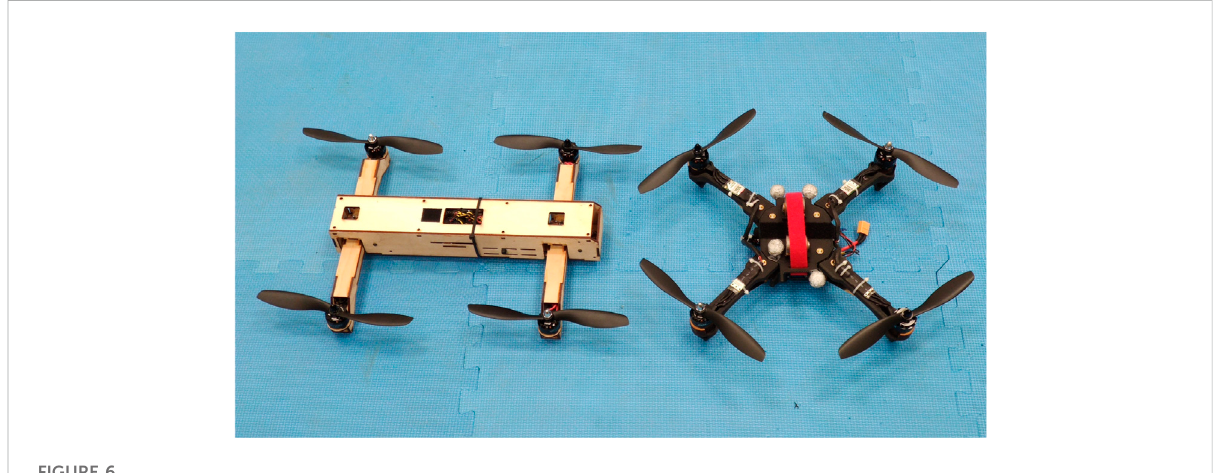
FIGURE 6 H-shaped(left)vs.X-shaped(right)quadcopterframe.UsingtheH-shapedframemeansthatasinglehingeandasinglespringcanbeusedtotilt two propellers at the same time, which reduces the mechanical complexity of the vehicle.